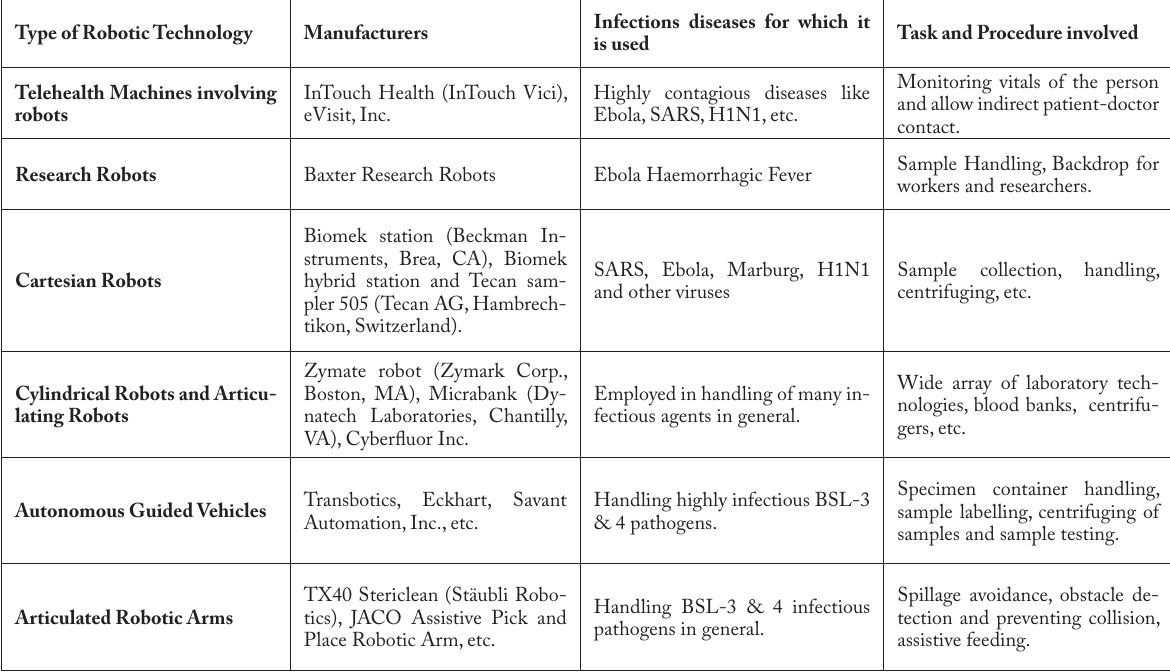
Table 3. Summary of different robotic technologies utilized in